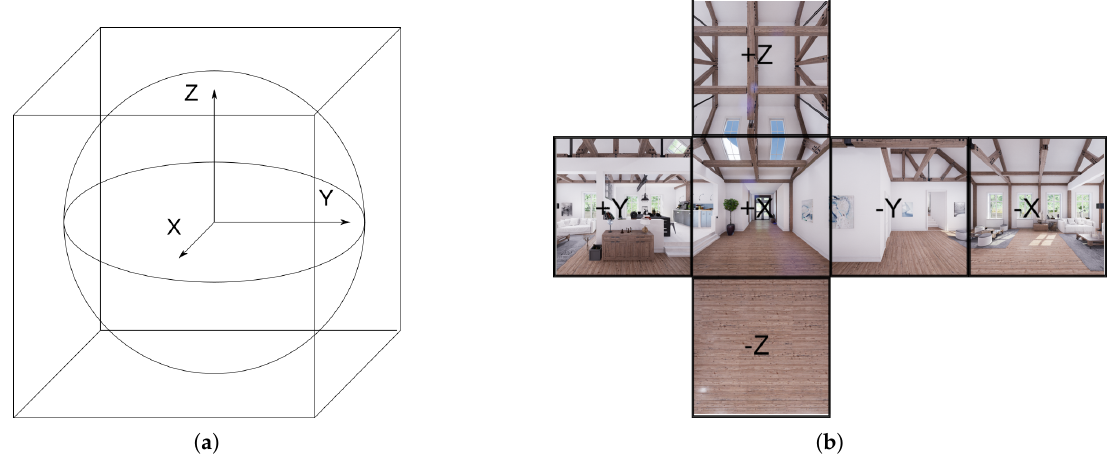
Figure 5. ( a ): Simplification of the sphere into the cube map; ( b ): Unfolded cube map from a